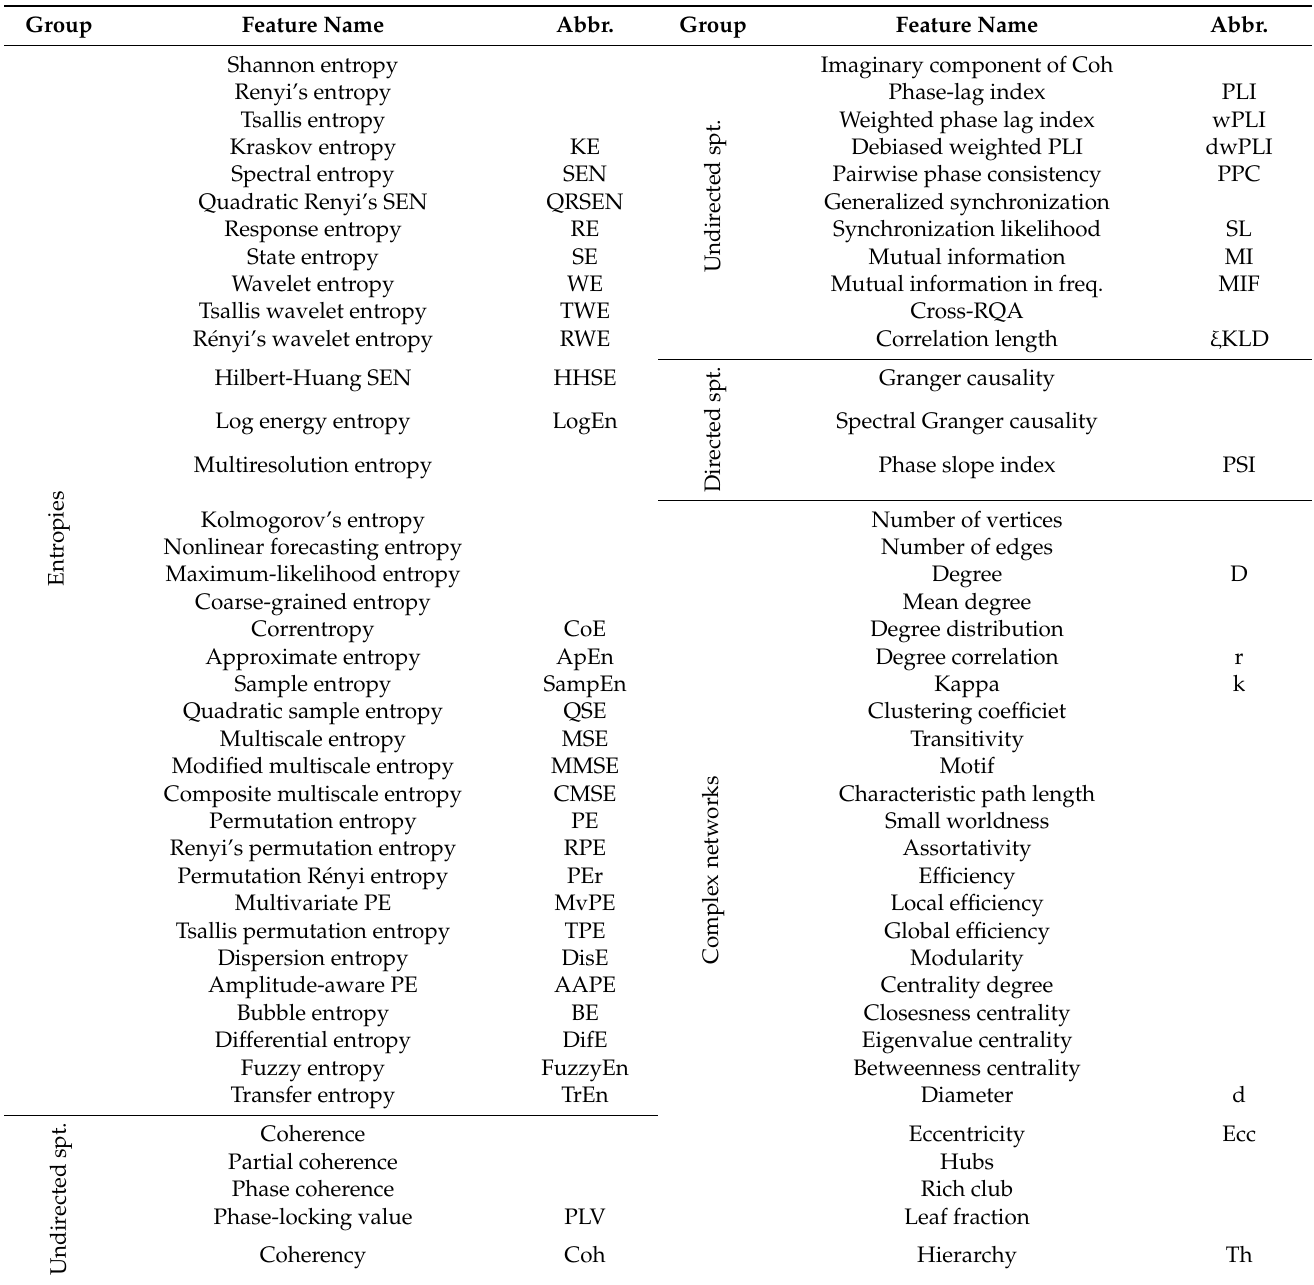
Table 2. The list of entropies, undirected and directed spatiotemporal (spt.), and complex network features reviewed in this